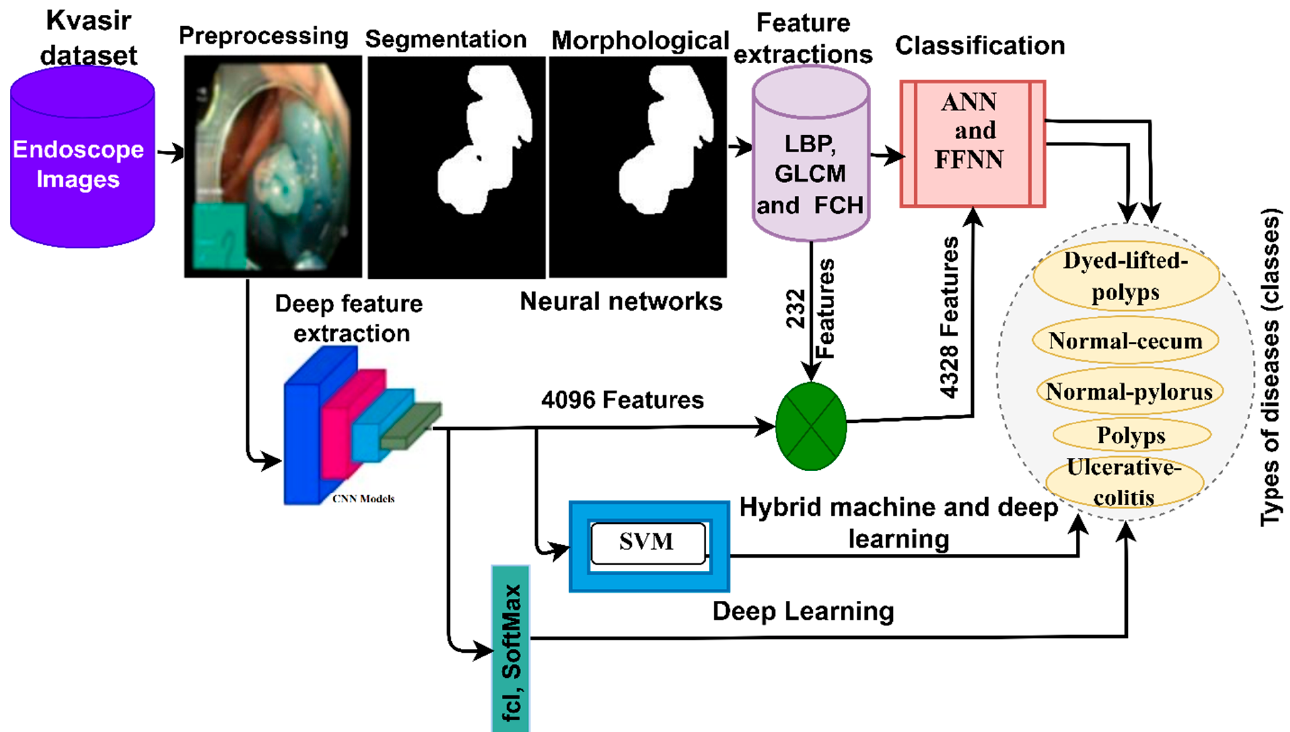
Figure 1. The general methodology for diagnosing lower GI disease dataset.